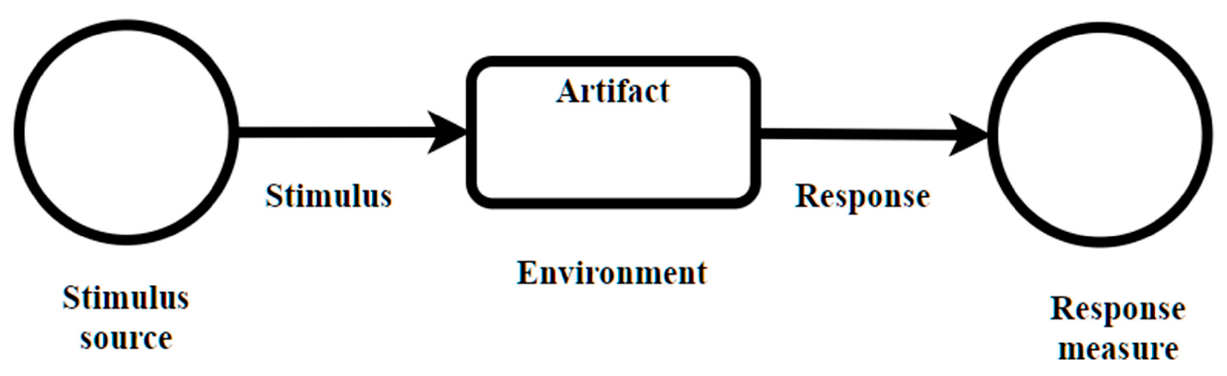
Figure 4. Scenario definition.